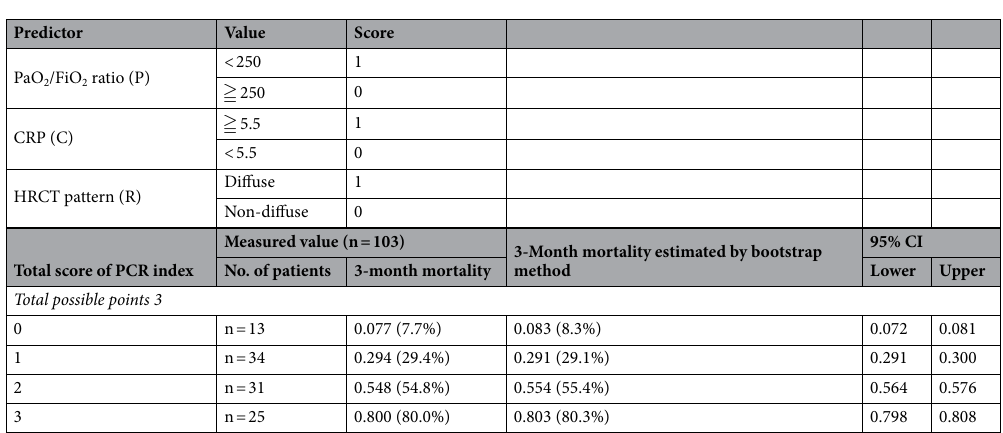
Table 4. PCR index and grading system. CI, confidence interval; HRCT, high-resolution computed tomography; CRP, C-reactive protein.